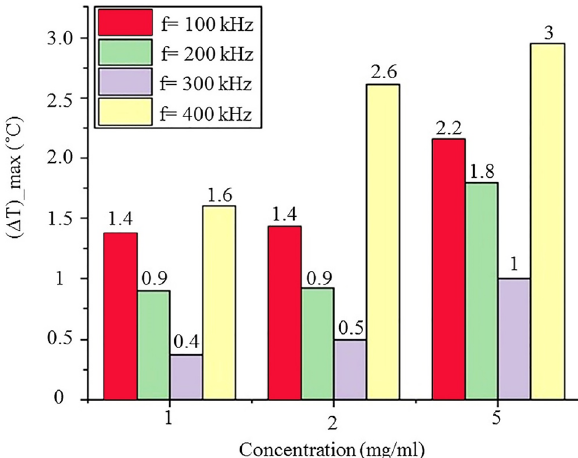
Figure 7. Changes in temperature versus the concentration the MNPs in the sample at the frequencies of 100, 200, 300, and 400